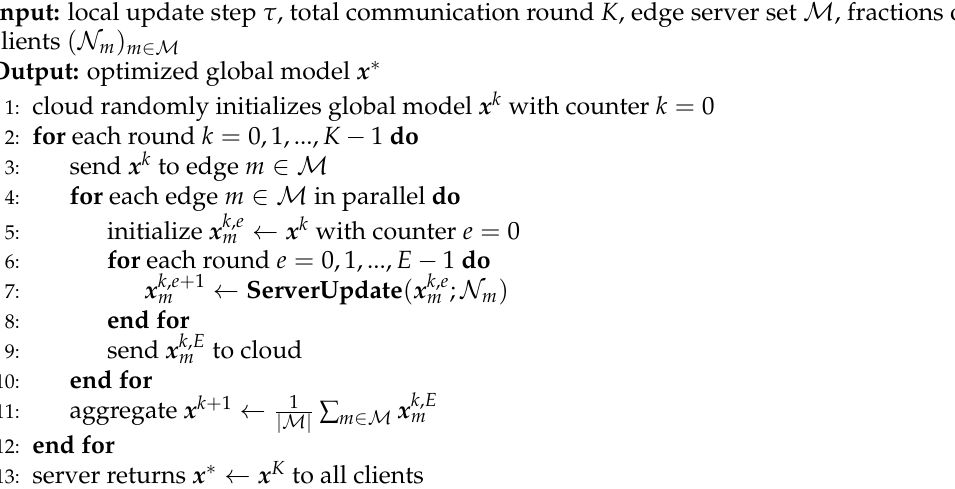
Algorithm 2 Hierarchical cloud–edge–client